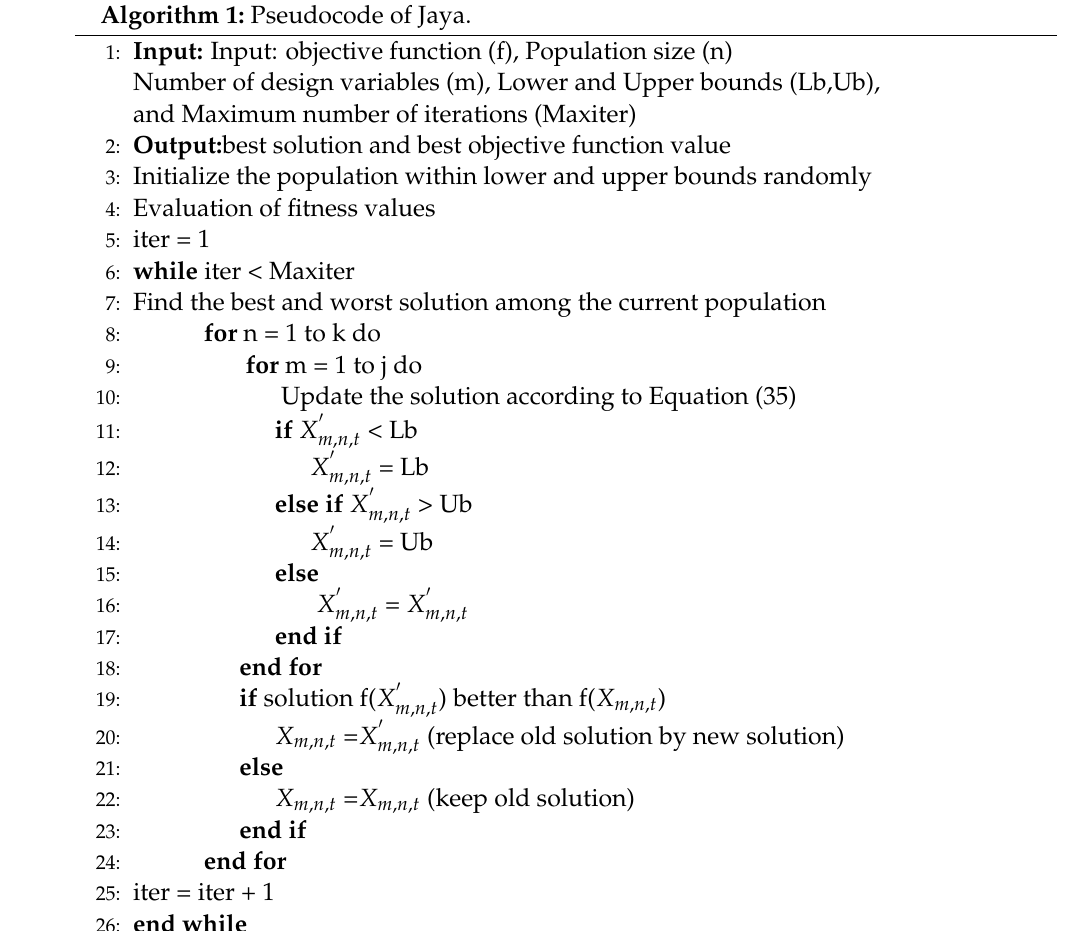
Algorithm 1: Pseudocode of